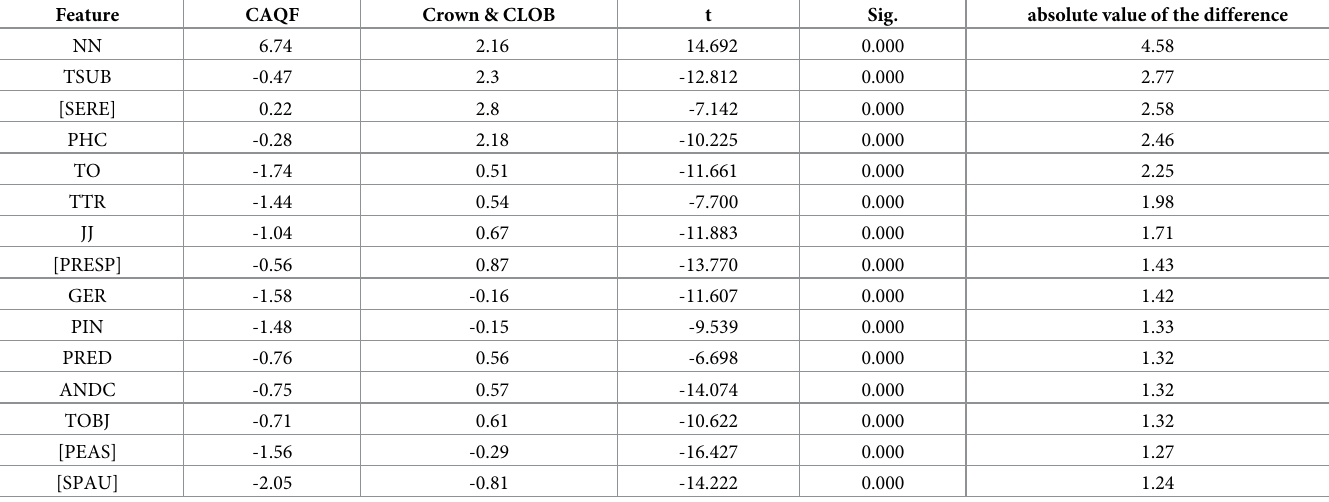
Table 3. Top 15 features with the largest differences in CAQF and Crown &